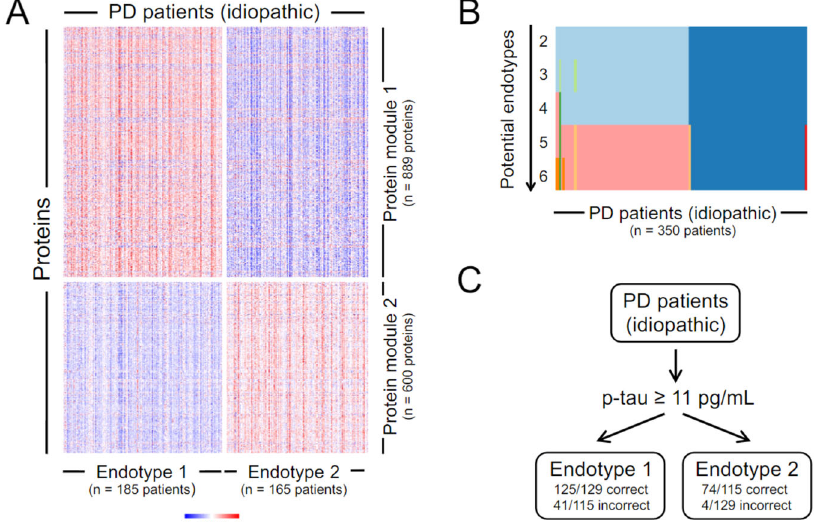
Fig. 3 Idiopathic PD endotypes. A Heatmap of z -scores of the protein values as measured with SomaScan, corresponding to the two modules identi fi ed using Weighted Gene Co-expression Network Analysis (WGCNA). The proteins in these modules are used for cluster analysis using Consensus Clustering, which retrieves two clusters (endotypes) of idiopathic PD patients. Patients are shown in the x -axis, separated by endotype, while proteins are shown in the y -axis, separated by module. B Tracking plot depicting how the idiopathic PD patients are assigned to speci fi c endotypes by Consensus Clustering as the number of potential endotypes increases. C Partition tree predicting endotype membership of the idiopathic PD patients based on clinical variables only. One node suf fi ces to separate patients into endotypes based on phospho-tau levels (p-tau) in CSF as measured with a clinical assay, the cut-off being 11